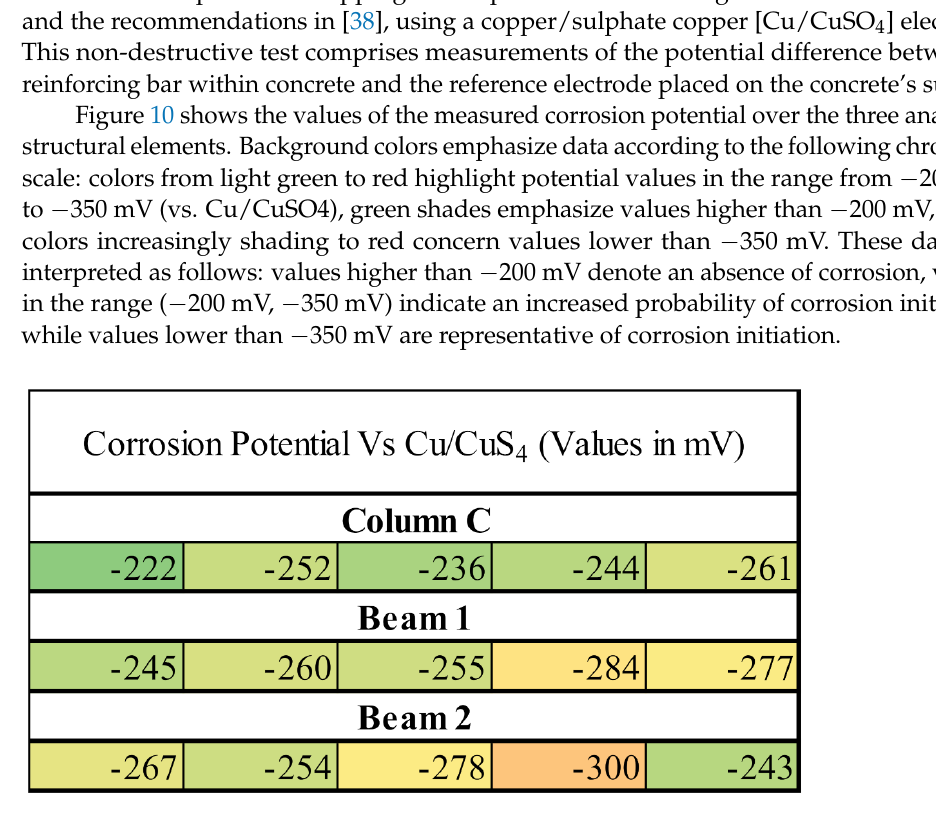
Figure 10. Potential values measured over the structural elements (meaning of background colors is described in the main